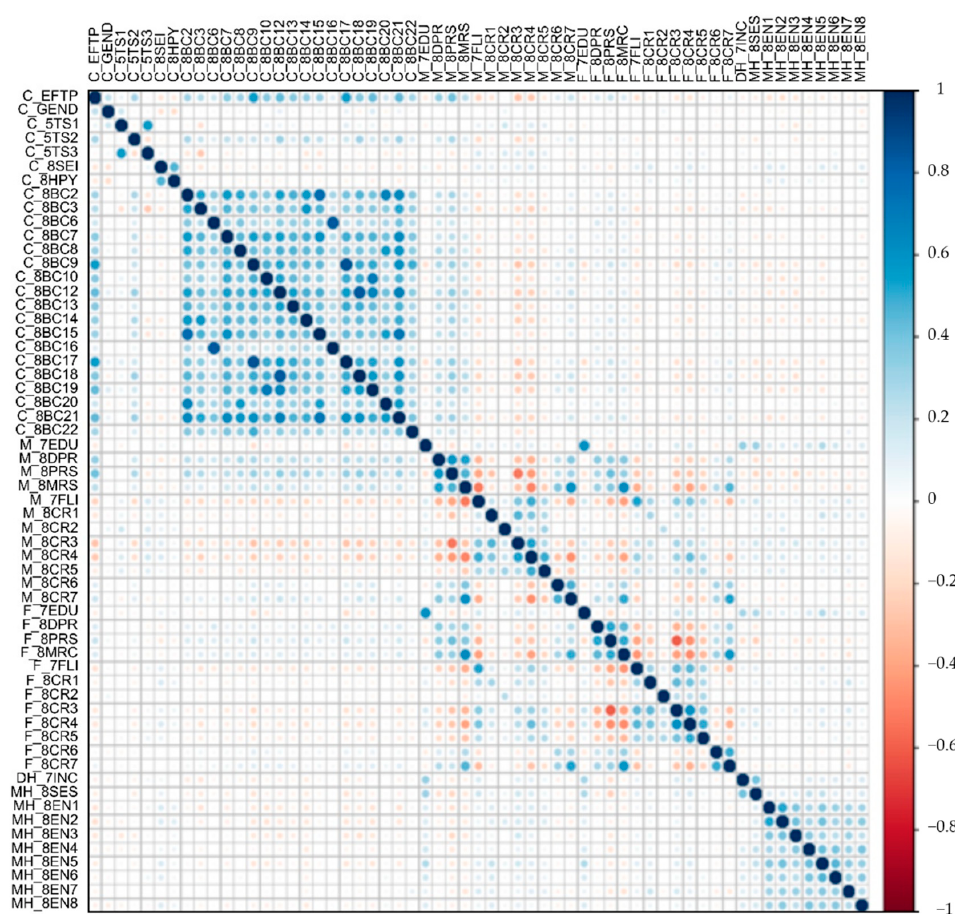
Figure 4. Spearman’s rank correlation analysis. When the risk of children’s EFD is taken as the ordinal variable, the larger the circle, the greater the probability of rejecting the null hypothesis of the rank correlation. The darker the blue, the greater the positive correlation, and the darker the red, the greater the negative correlation.